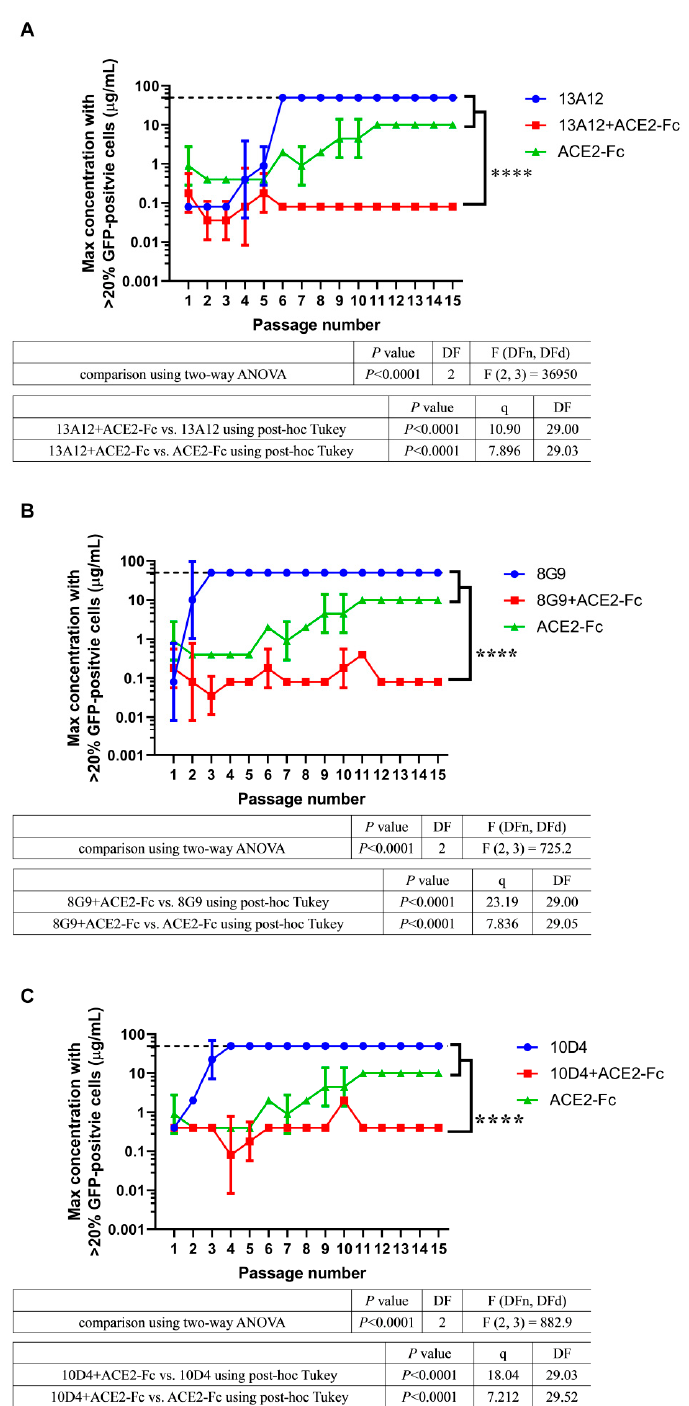
Figure 4. ACE2-Fc has the potential for cocktail therapy. Three cocktails, ( A ) ACE2-Fc + 13A12, ( B ) ACE2-Fc + 8G9, and ( C ) ACE2-Fc + 10D4, were evaluated in the 45 d VSV-SARS-CoV-2-S viral evolution. These cocktails achieved both efficacy and breadth throughout the evolution of the virus. The dashed line represents the concentration of 50 µ g/mL. Within six passages, viruses have evolved to escape 50 µ g/mL antibodies. The suboptimal concentrations that permitted viral replication from two independent experiments ( n = 2) are shown as mean ± SD. The passage number–suboptimal concentration curve of ACE2-Fc from Figure 3A was superimposed to graphs of each cocktail. The significant differences were evaluated using two-way ANOVA statistical analysis with a post hoc correction (Tukey test) for family-wise error rate. **** p <